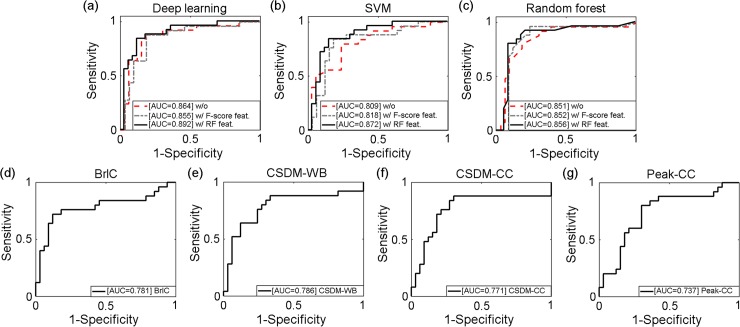
Comparisons of ROCs based on the testing dataset for the total of 7 classifiers.